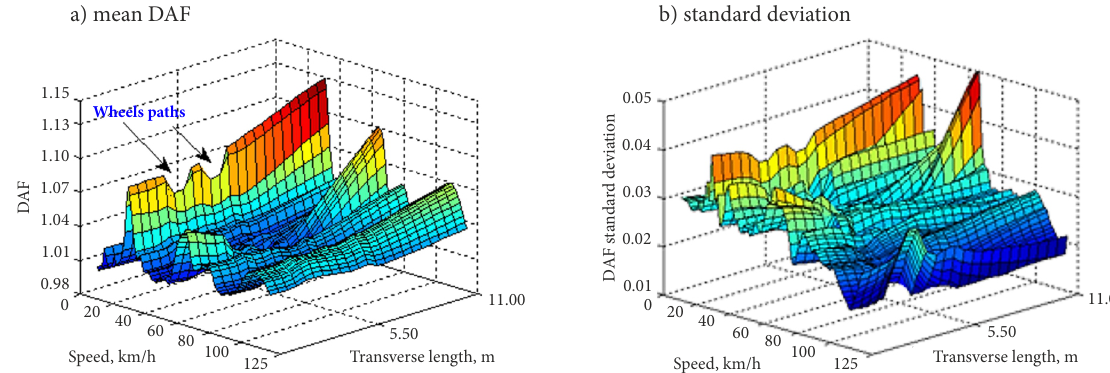
Figure 11. DAF-speed for plate model due to long vehicle on class A